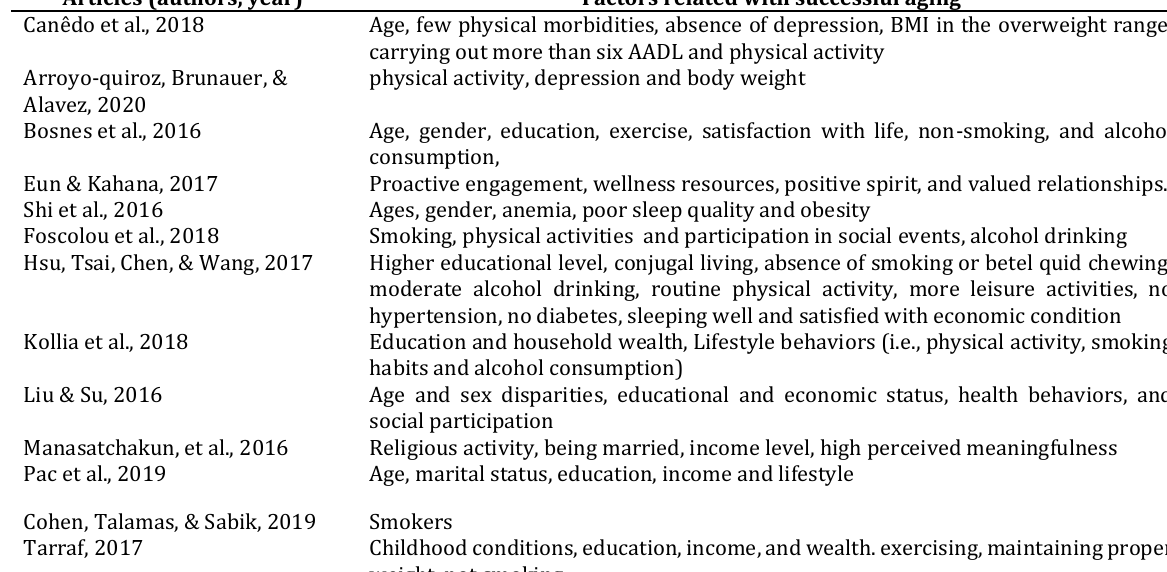
Table 3. Overview of included study (Factors related with successful aging) Articles (authors,